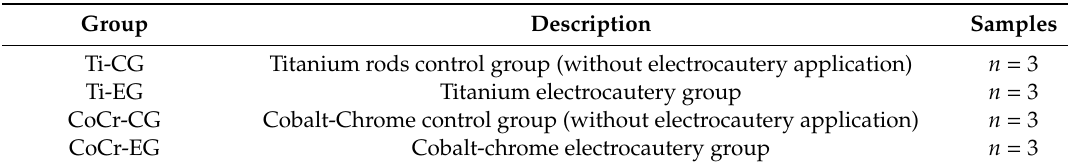
Table 1. Specimen grouping matrix.